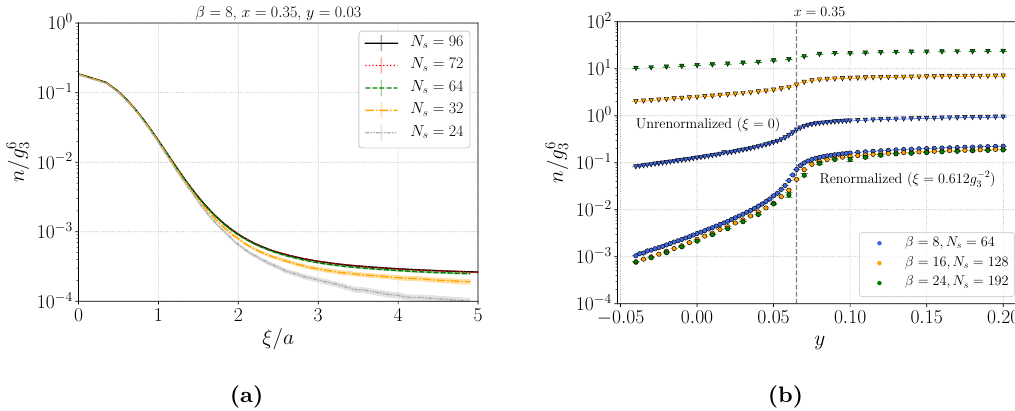
Figure 4 . (a) Evolution of the monopole number density during gradient flow at different volumes and fixed β = 8 . (b) Renormalized and unrenormalized number densities as functions of y , at different values of β . The dashed line indicates where the crossover transition takes